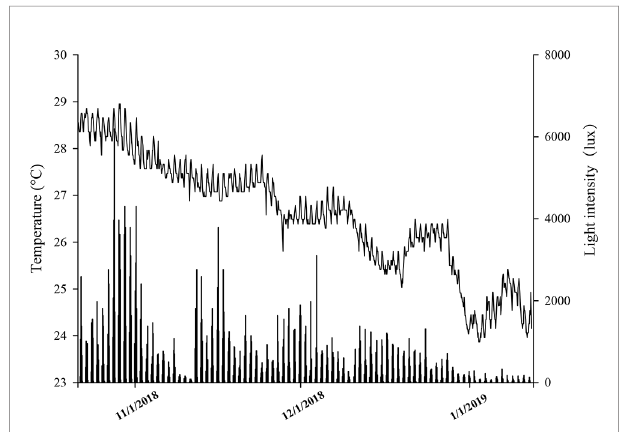
FIGURE 1 | The temperature (°C) and light intensity (lux) of Luhuitou fringing reef (3m) from October 2018 to January